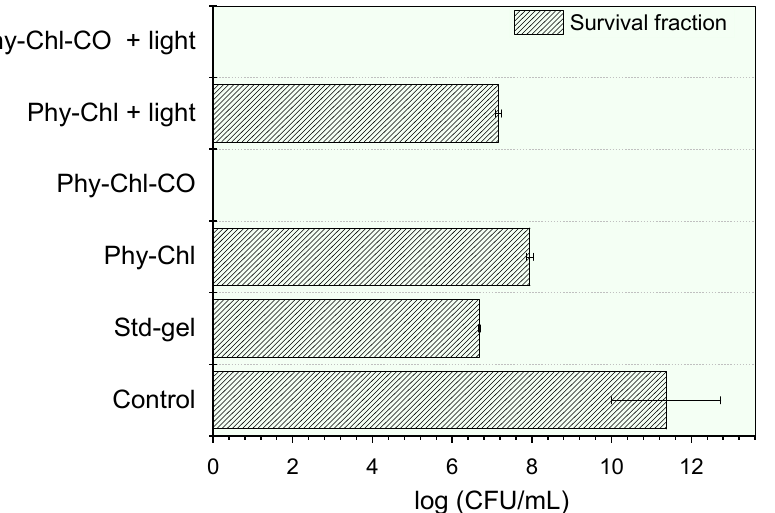
Figure 10. Inactivation of S. aureus by a set of phytotherapeutic gels applied to PDT. The absence of bars indicates the complete elimination of the microbial load.